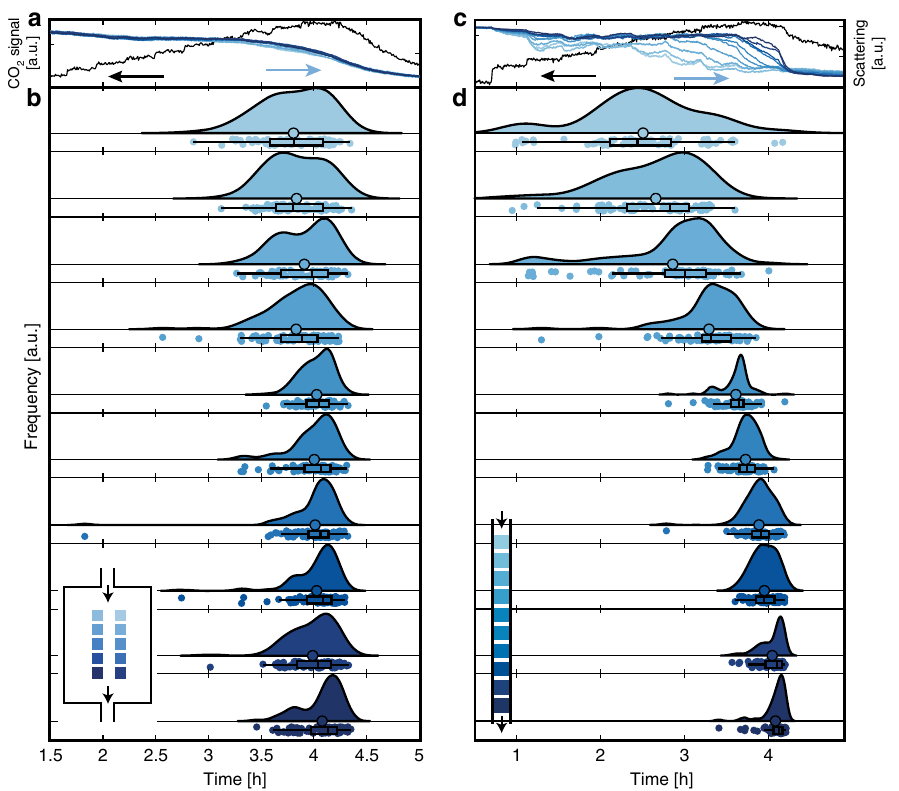
Fig. 8 Single Cu particle oxidation time analysis for the two reactors. a CO 2 production measured by the QMS at the outlet of the well-mixed reactor (black, left axis) together with the integrated scattering intensity for each of the ten patches (blue, right axis). b Oxidation times for the individual particles in the well-mixed reactor, presented as half violin plots. Each distribution corresponds to data collected from the 100 single particles contained within a patch, with each patch outlined and color-coded in the inset. Below each of the distributions are the individual particle data points presented as colored dots, the mean oxidation time (outlined large circle) and a box plot showing the median oxidation time, the inner percentile (box) and whiskers corresponding to the lower/upper adjacent values (horizontal line). c , d Same as ( a , b ) but for the plug- fl ow reactor. Note the slightly different scale on the x